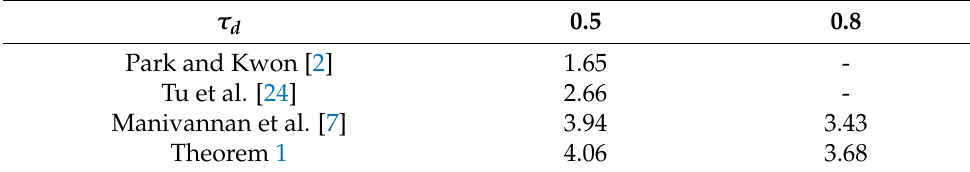
Table 1. The maximum upper bound of γ for different τ d .